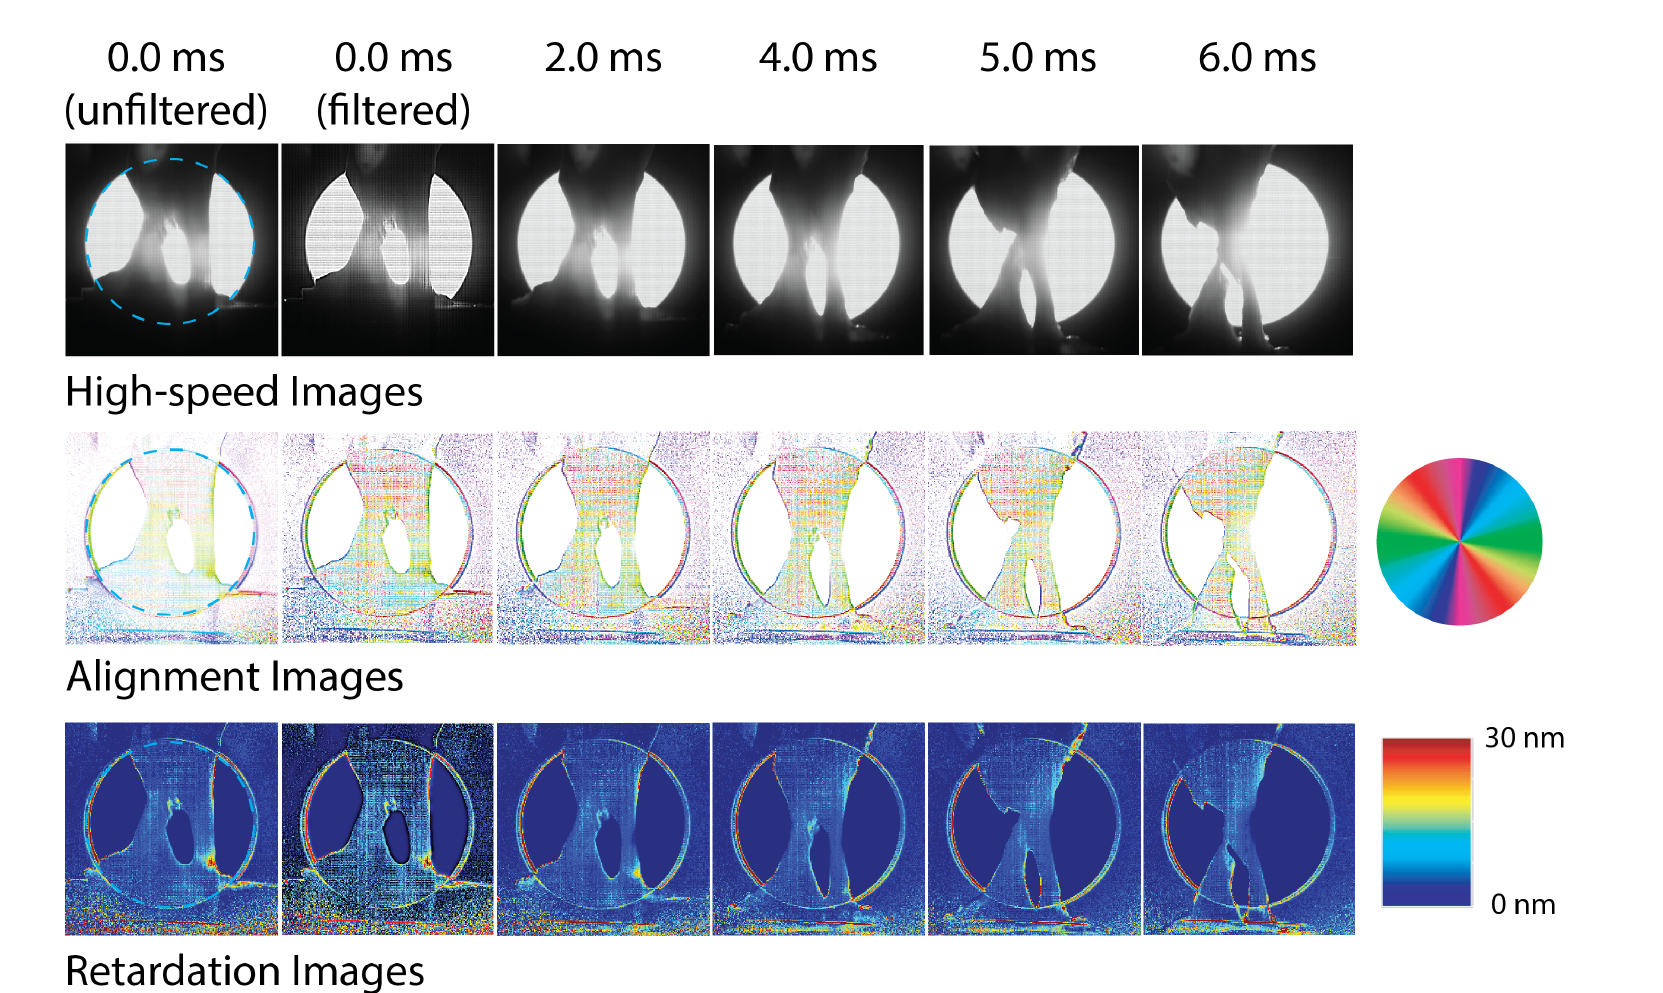
Figure 8. High-speed images recorded for tendon-to-bone insertion specimen 2 using the high-speed polarization-filter-array camera and obtained optical axis alignment angle and retardation images. Field of view is shown as a blue dashed circle in images at 0 ms. Filtered and non-filtered images shown for 0.0 ms. For later time steps, the alignment angle images were filtered; the video and retardation images were